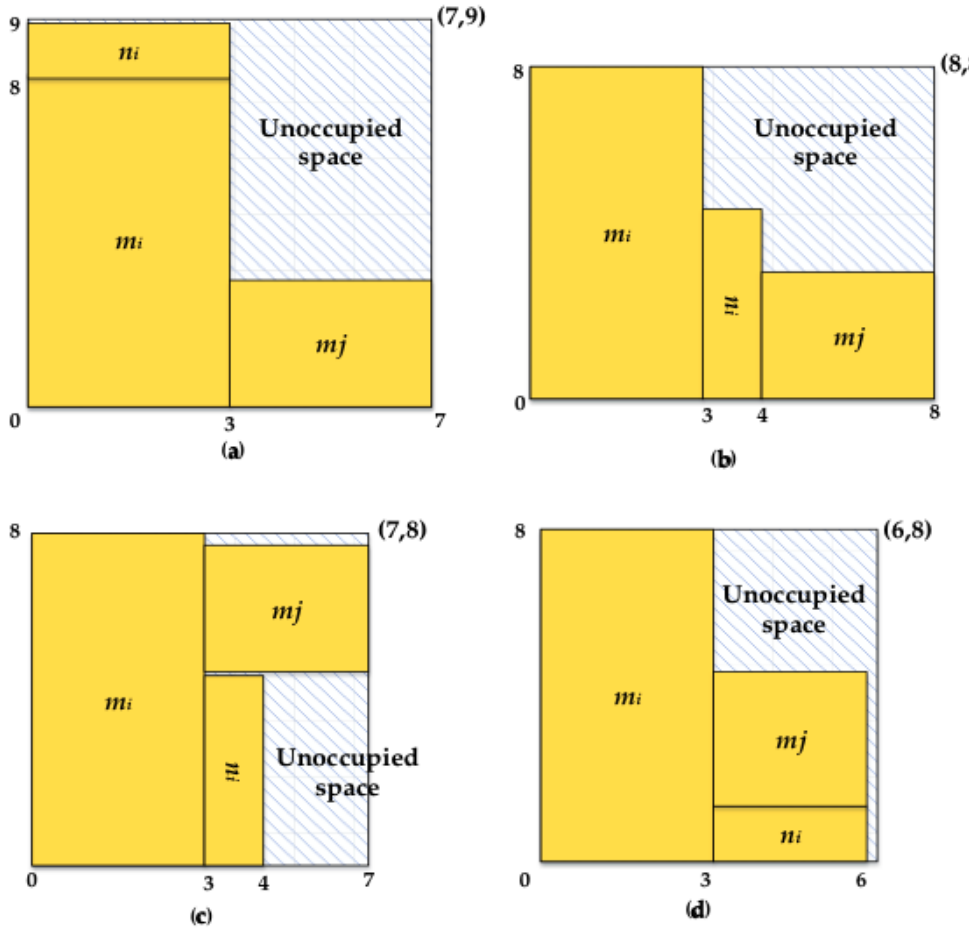
Figure 7. Proposed placement methodology. ( a ) Positioning of n i above m i , ( b ) Unoccupied space